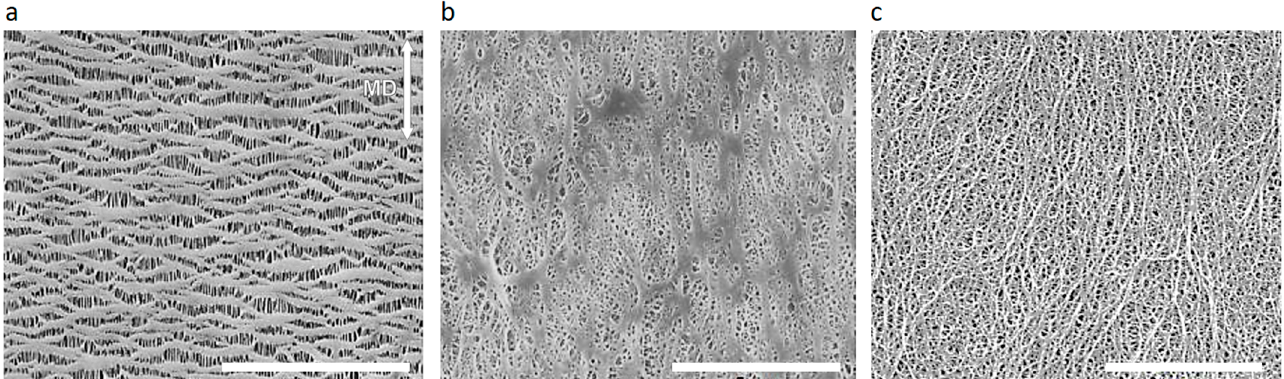
Figure 3. SEM micrographs of microporous polyolefin membranes at the surfaces. ( a ) Uniaxially stretched dry-processed PP separator. ( b ) Biaxially stretched dry-processed β -nucleated PP separator. ( c ) Biaxially stretched wet-processed PE separator. (scale bar = 5 µm) Reproduced with permission from [14].